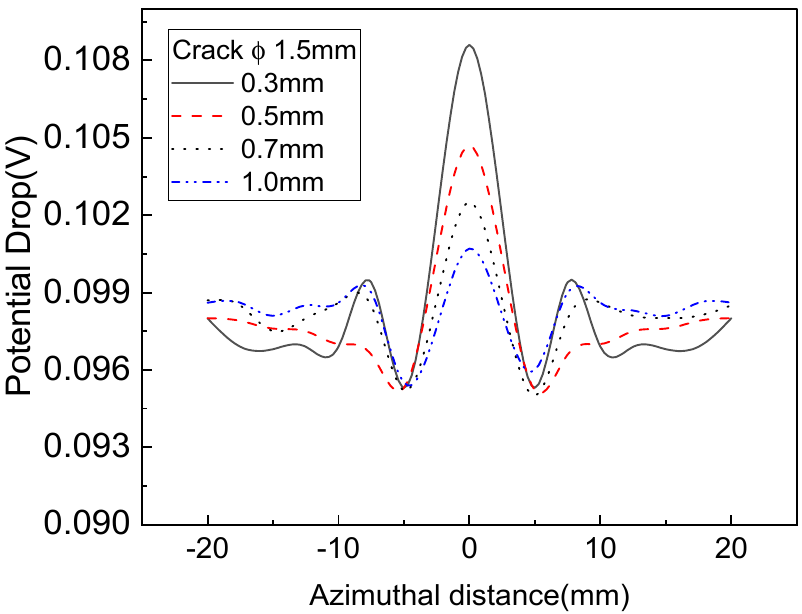
Figure 9. Variations of potential drop with different defect depths for a subsurface crack of 1.5 mm.